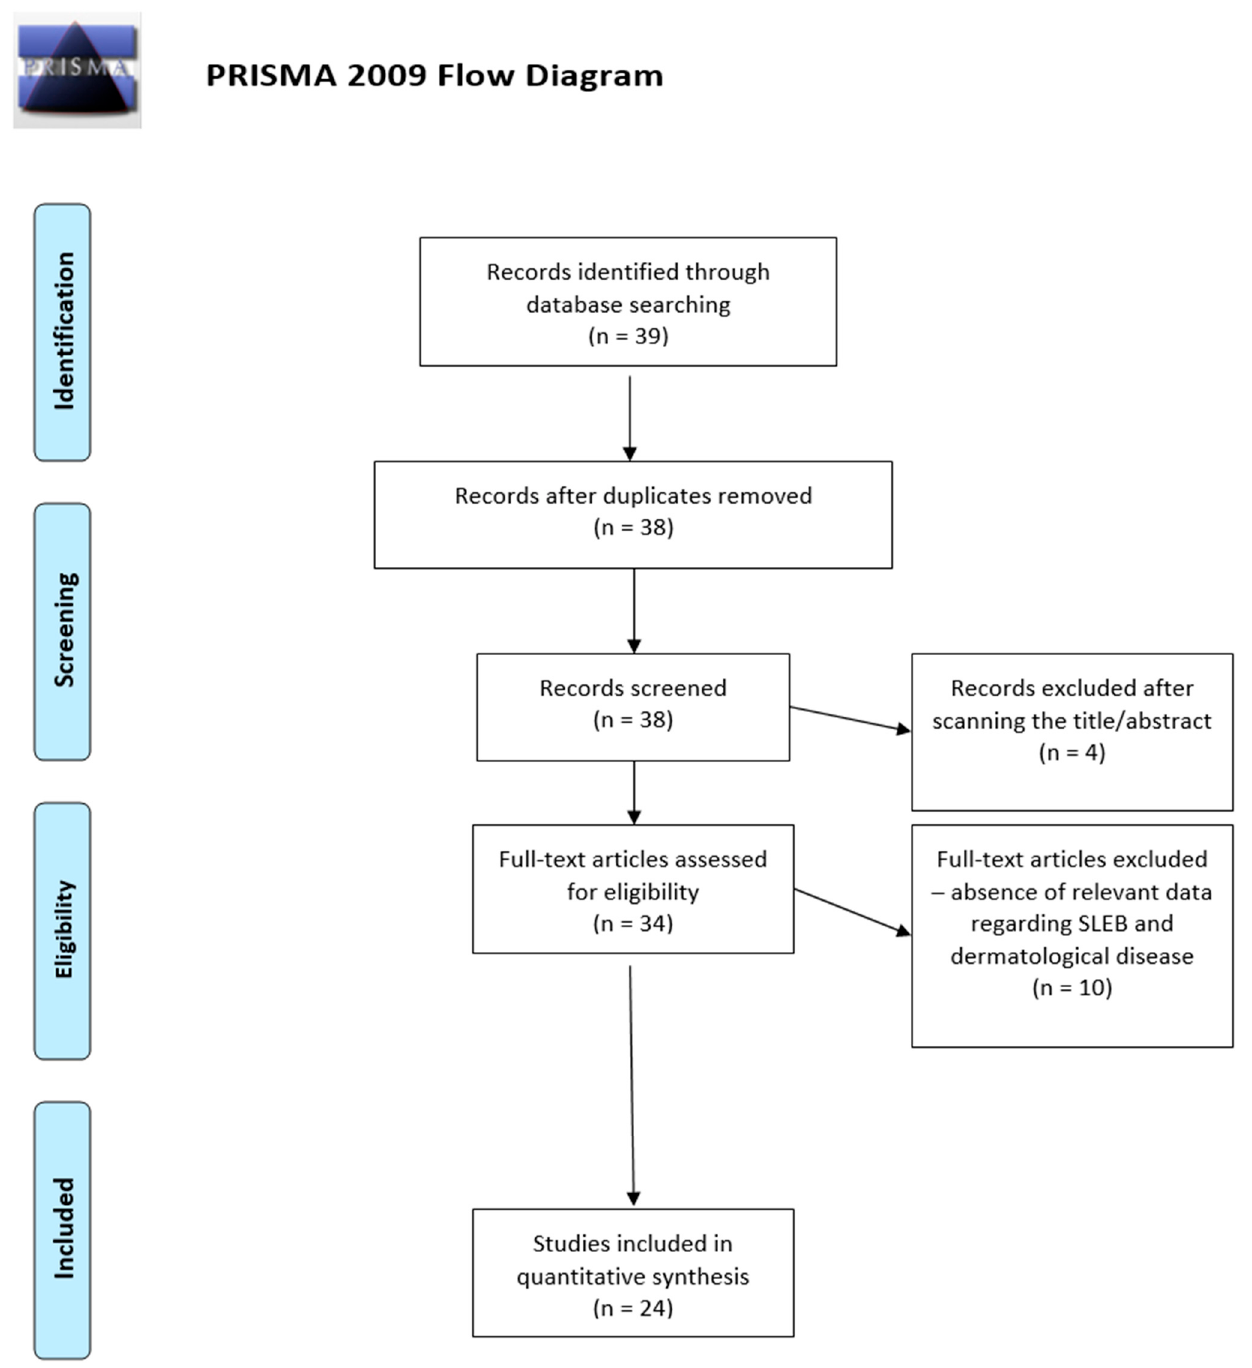
Figure 1. PRISMA 2009 flow diagram depicting the selection process of the articles included in the systematic review [5] .